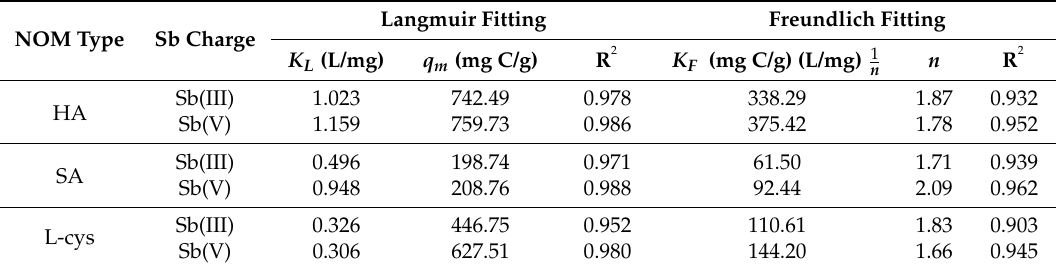
Figure 5. Langmuir and Freundlich fitting of NOM adsorption data in ( A , B ) Sb(III); and ( C , D ) Sb(V) systems at pH 7 ± 0.1. Table 1. Adsorption isotherm fitting parameters of HA, SA, and L-cys on Fe precipitates in Sb(III) and Sb(V)